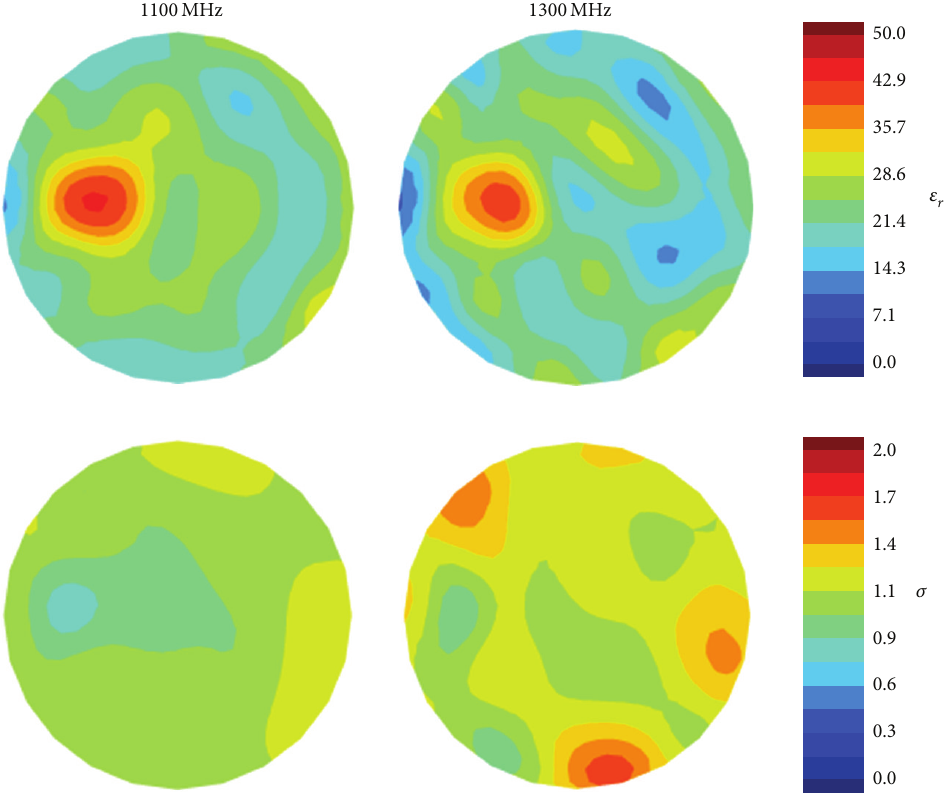
Figure 6: Reconstructed 1100 and 1300 MHz permittivity and conductivity images from measured data.